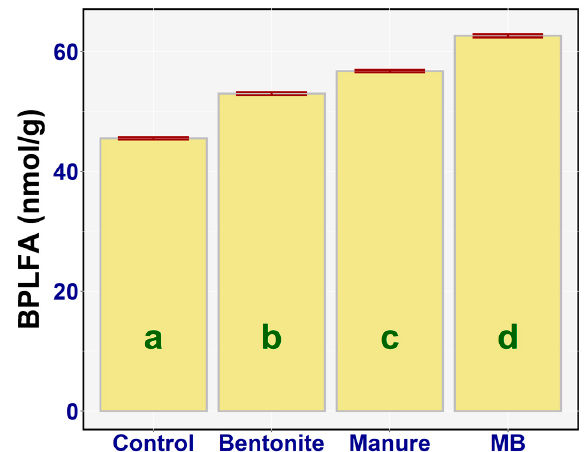
Figure 6. Amount of BPLFA (nmol/g) in the treatments: means with SEM.